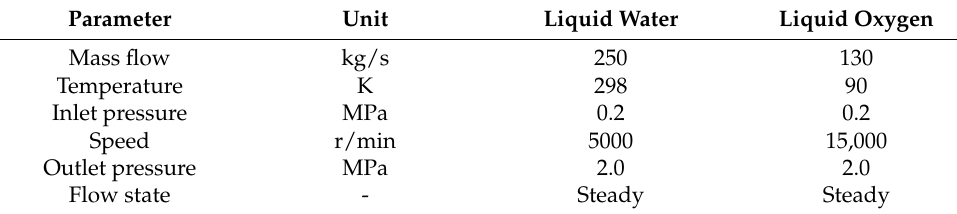
Table 2. The relevant parameters of the numerical calculations.